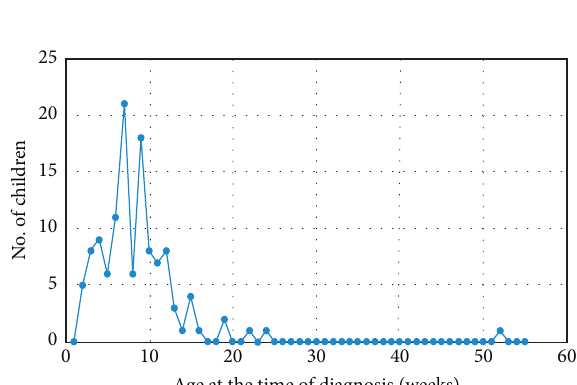
Figure 3: Age distribution of infants with biliary atresia at the time of